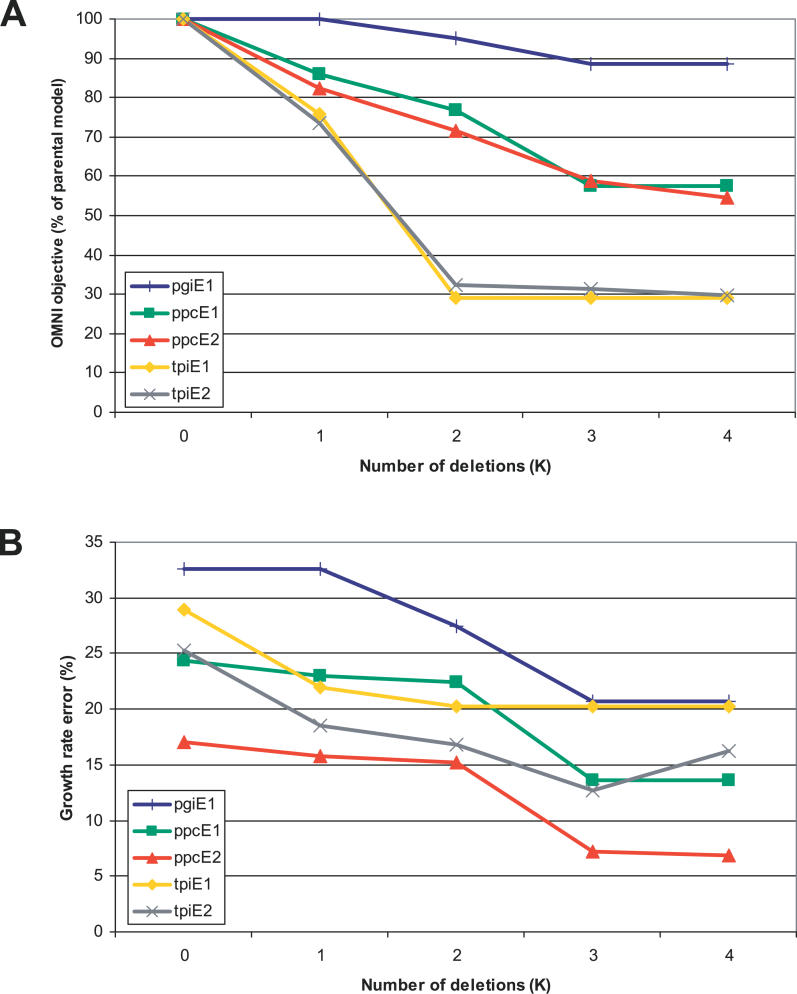
The Dependence of the Model Prediction Errors on the Number of Reactions Deleted from the Parental Strain Model(A) The overall combined intracellular and growth rate prediction error as measured by the percentage of the OMNI objective value for the optimal modified model compared with the objective value for the parental strain model.(B) The growth rate prediction error (percentage of the experimental growth rate) for the optimal modified model identified by the OMNI method.